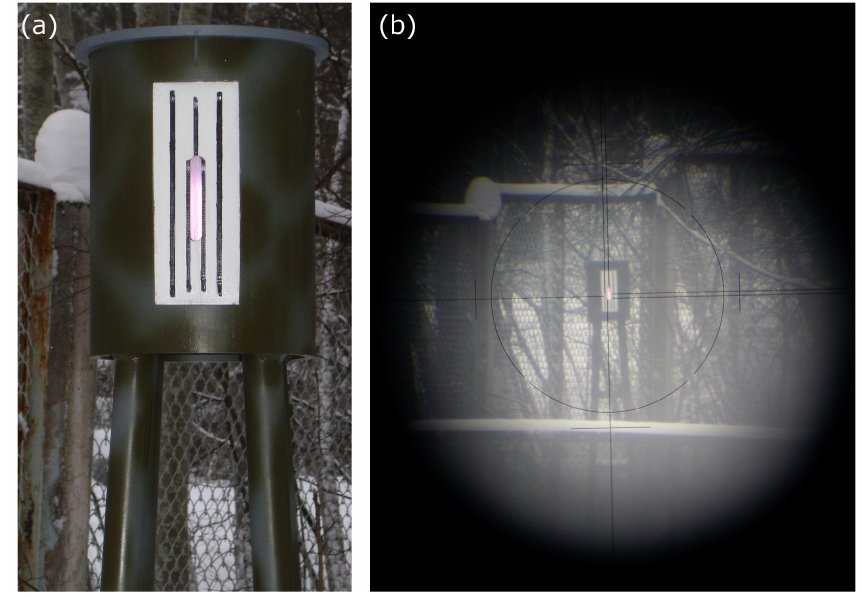
Figure 4. Reference azimuth mark. The light bulb compartment (a) and the view of the mark from the absolute pavilion (b)